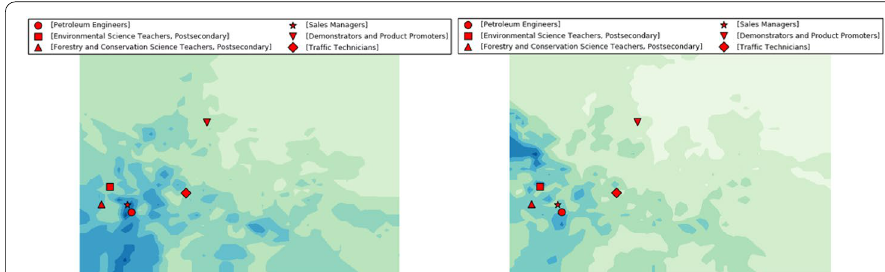
Fig. 8 LSI Heatmap for GCC oil & gas Demand (left) and Supply (right)